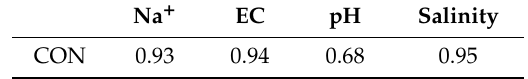
Table 4. Correlation coe ffi cients between CON and four main soil properties of